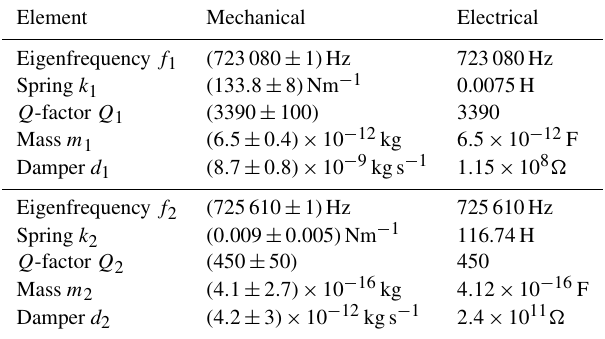
Table 2. Values for the mechanical and electrical elements, the lat- ter being calculated according to Table